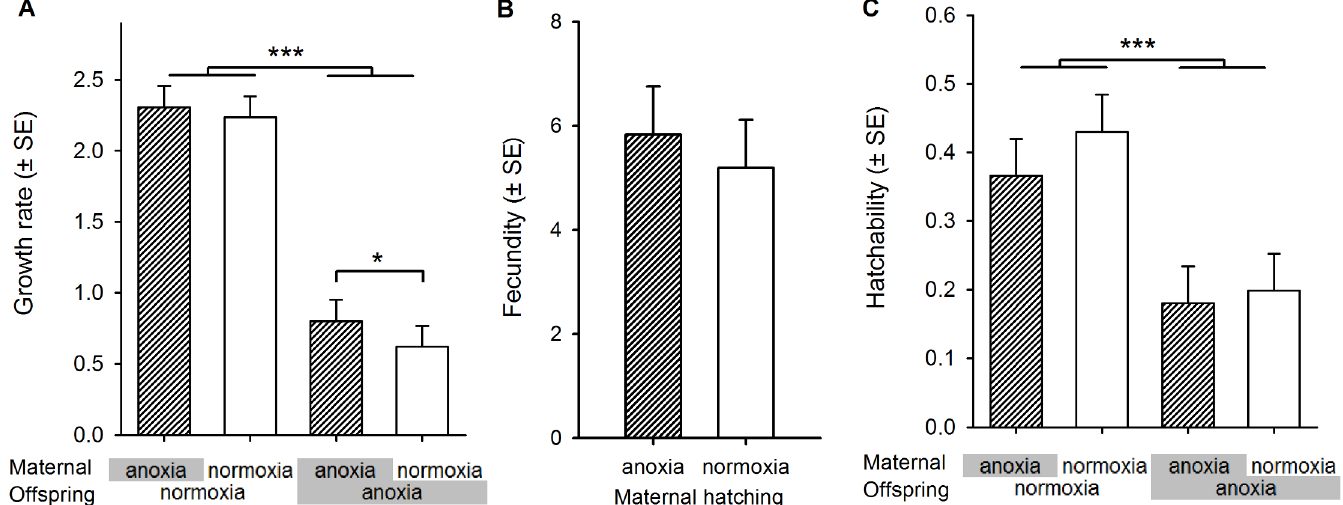
Fig 2. Fitness and fitness components in the ancestor high-salt normoxia-adapted population. (A) The natural logarithm of the growth rate of the high- salt-adapted population (ancestral to the populations used in the present study) across the four possible maternal – offspring hatching environments. Over one full life cycle, ln growth rate is an estimate of the absolute fitness with positive values indicating that the population would grow exponentially with unlimited resources. (B) The fecundity of hermaphrodites deprived of oxygen during embryogenesis is not affected relative to normoxia rearing condition. (C) Embryo hatchability to the L1 stage after anoxia exposure is severely hampered, independently of maternal hatching environment. (A – C) We employed linear mixed-effect models (LMM) [56], taking sample thawing block as a random factor and maternal hatching treatment, in the case of fecundity, or maternal and offspring hatching treatments, in the case of growth rate and hatchability, as fixed factors (see Materials and Methods for further details). Planned contrasts were then done with post-hoc Tukey t tests [57] and LMM-corrected Kenward-Roger (KR) degrees of freedom [58]: * p < 0.05, *** p < 0.001. Data deposited in the Dryad repository: http://dx.doi.org/10.5061/dryad.56bb4